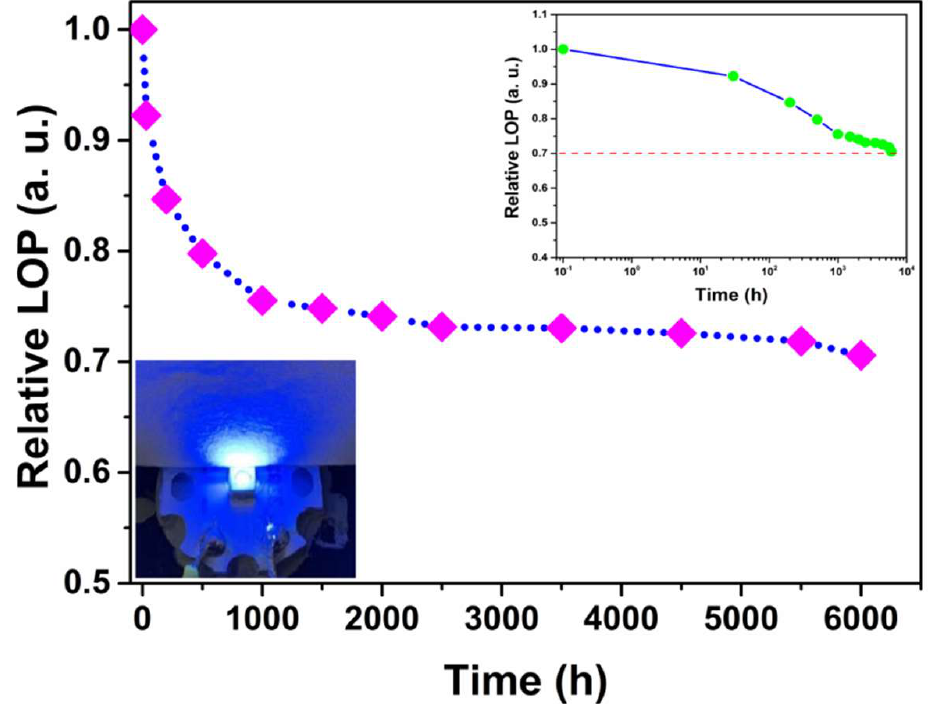
Figure 4. Normalized QW intensities of the peak wavelengths of the AlGaN-based UVB-LED measured at temperatures of 298, 323, and 348 K while applying forward currents from 10 to 130 mA at a step of 30 mA.